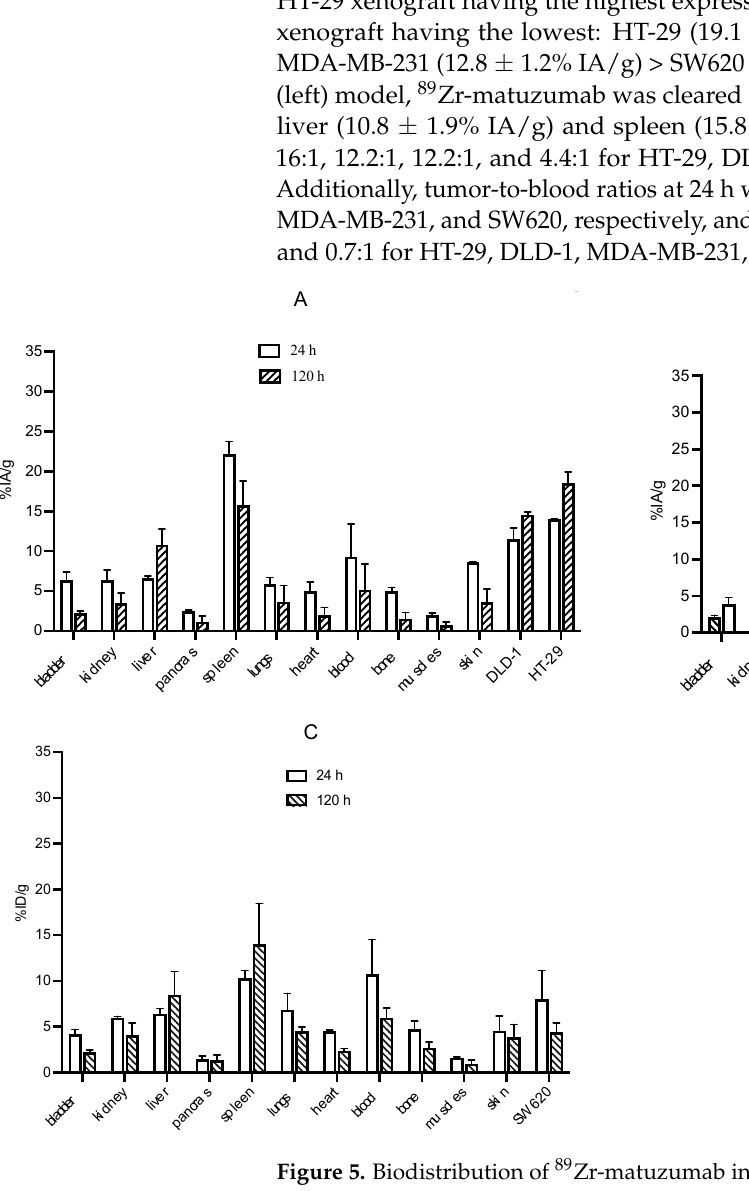
Figure 6. In vivo epitope-specific imaging and biodistribution. ( A ) CD-1 athymic nude mice bearing EGFR-positive DLD-1 (left flank) and HT-29 (right flank) were pre-dosed with excess (50-fold of the imaging dose) of nimotuzumab 24 h prior to administration of 89 Zr-matuzumab followed by mi- croPET/CT imaging. ( B ) Ex vivo biodistribution of the mice at 120 h post-injection. 89 Zr-matuzumab exhibited biphasic clearance with fast distribution clearance of t ½ α of 3.8 ± 0.27 h and a slow clearance of t ½ β of 165 ± 14 h (Figure 7, Table 1)